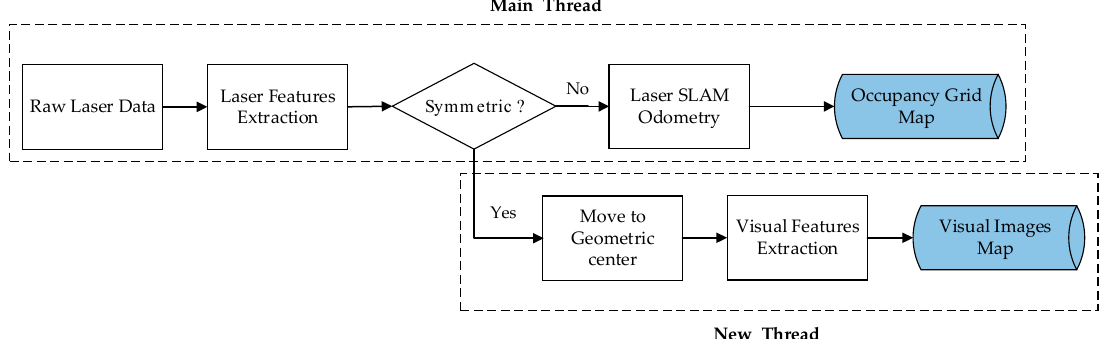
Figure 2. Map-building process.